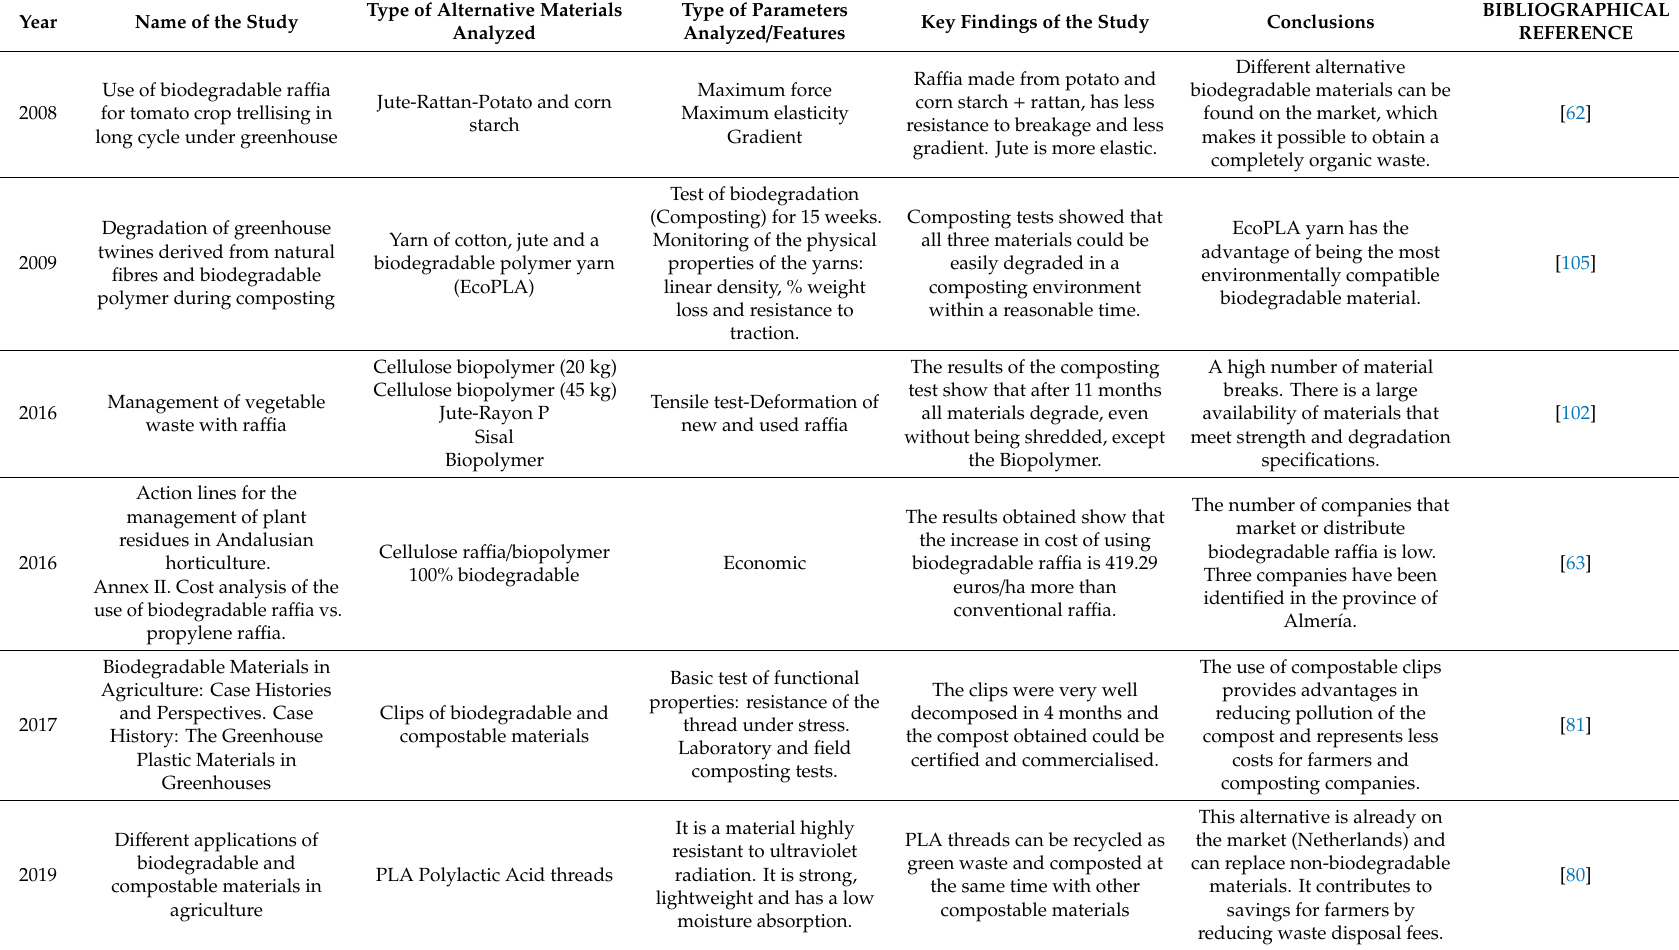
Table 1. Research related to the use of ra ffi a and other biodegradable fixing elements for crop